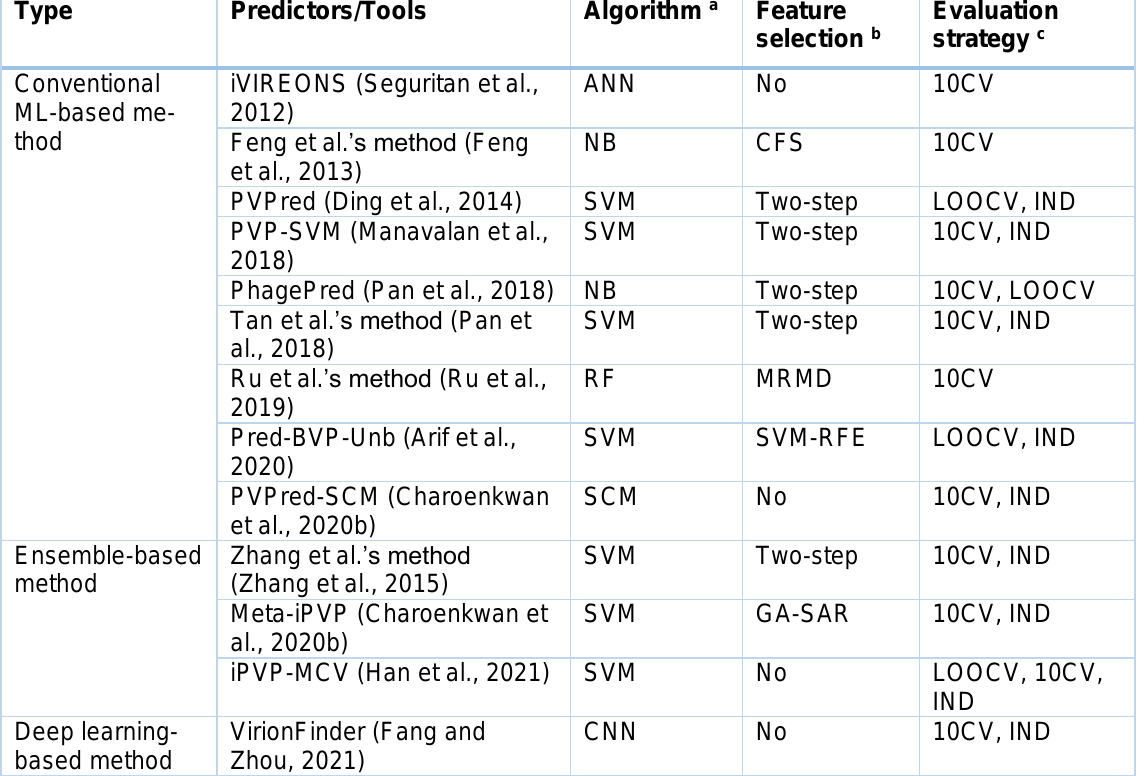
Table 1: A comprehensive list of current PVP predictors reviewed in this study Type Predictors/Tools Algorithm a Feature